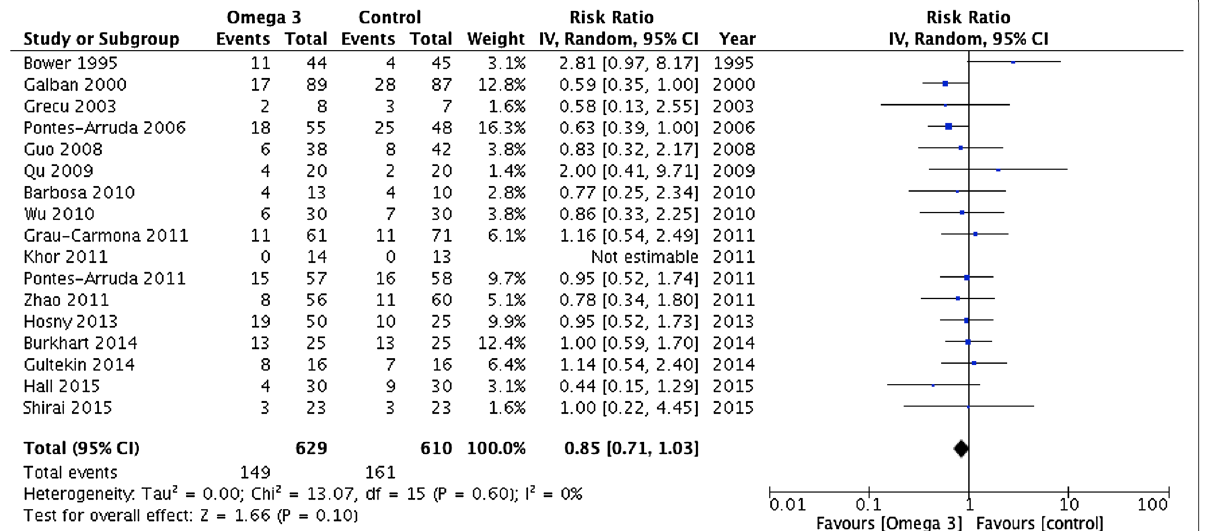
Fig. 3 Mortality outcome. Data from 17 trials ( n 1239 patients) were included and analysed using the random-effects model. Omega-3 supple- = mentation was associated with a non-significant reduction in mortality. ICU intensive care unit, IV inverse variance, RCT randomized clinical trial